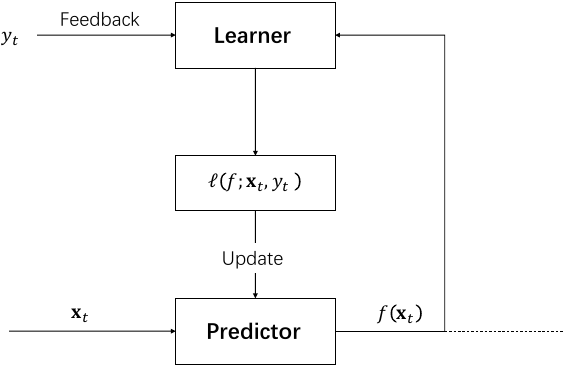
Figure 4. An illustration schematic of the online learning algorithm. Online learning is performed in a sequence of consecutive rounds. At each round t , the online learner picks a predictor f to make the prediction f ( x t ) . When the true label y t is revealed, the online learner suffers from an instantaneous loss (cid:96) ( f ; x t , y t ) and updates the predictor for the next